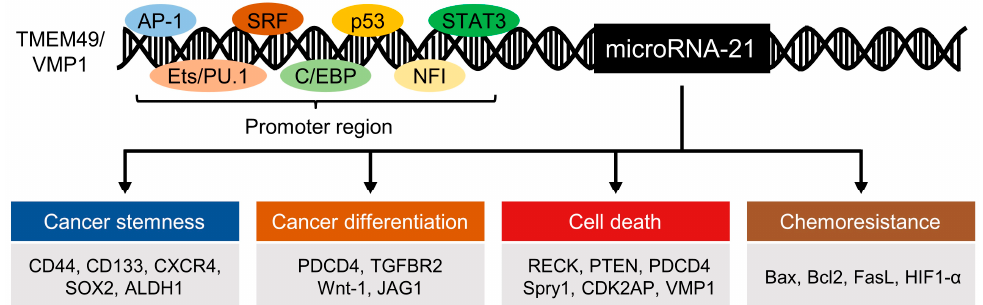
Figure 2. Epigenetic regulators of miR-21 and downstream targets of miR-21 in regards to cancer stemness, differentiation, cell death, and chemoresistance. Representative regulators of each cellular process are listed. TMEM49—transmembrane protein 49, VMP1—vacuole membrane protein 1, AP-